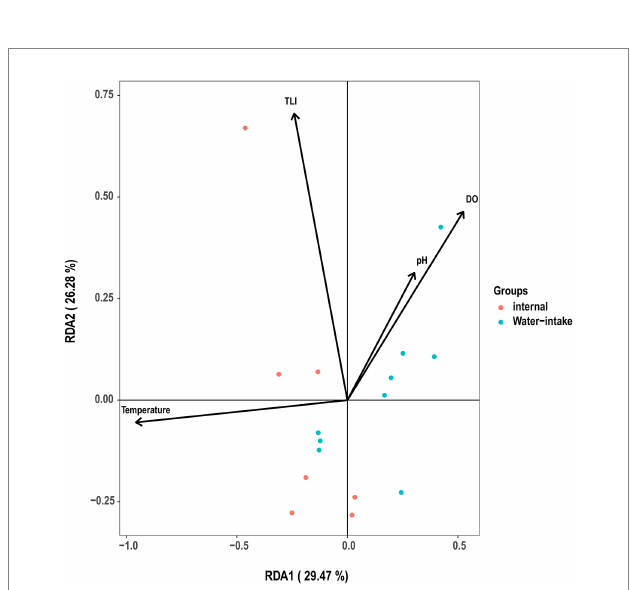
FIGURE 5 Redundancy analysis ordination diagram of all communities and environmental variables. Circles correspond to